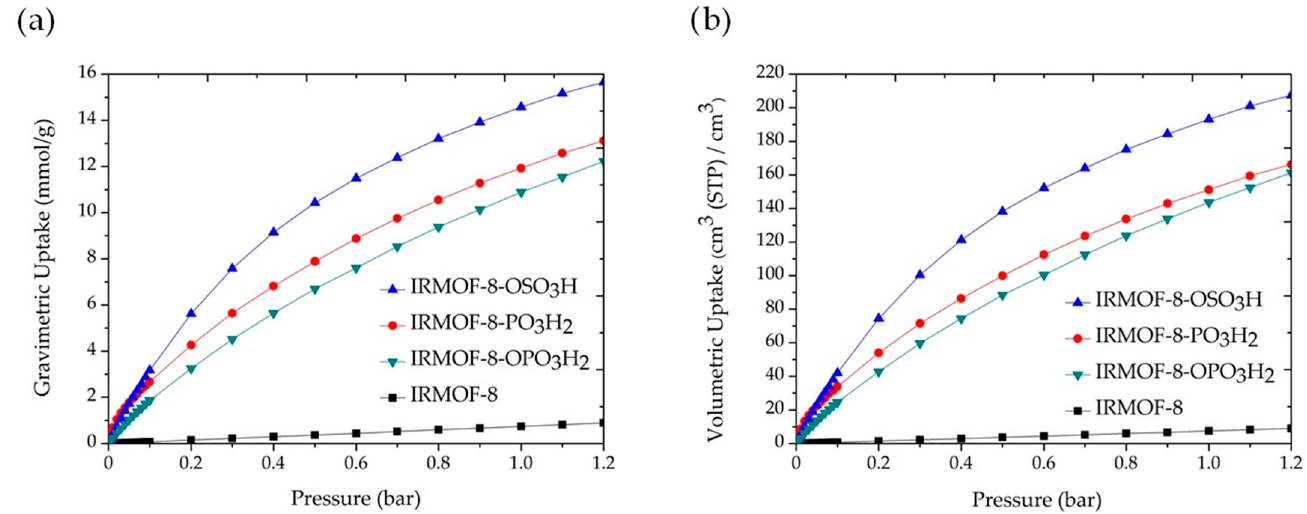
Figure 4. Gravimetric ( a ) and volumetric ( b ) NO 2 uptake isotherms for IRMOF-8 and IRMOF-8-X (X: -OSO 3 H, -PO 3 H 2 , -OPO 3 H 2 ) at 298 K.